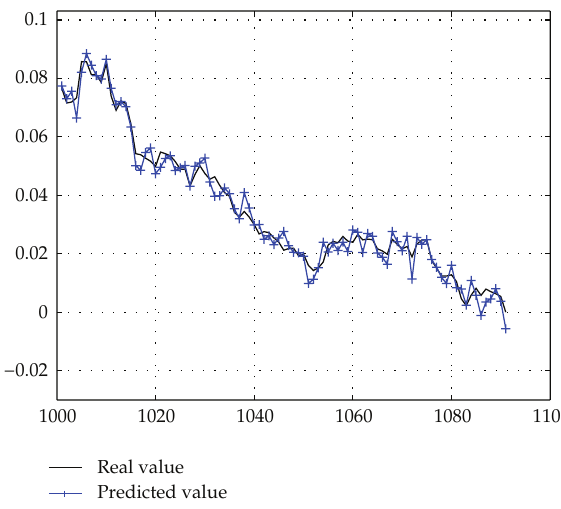
Figure 4: Predicted result of Shenzhen component index (cid:4) 500 fitting data (cid:5) .